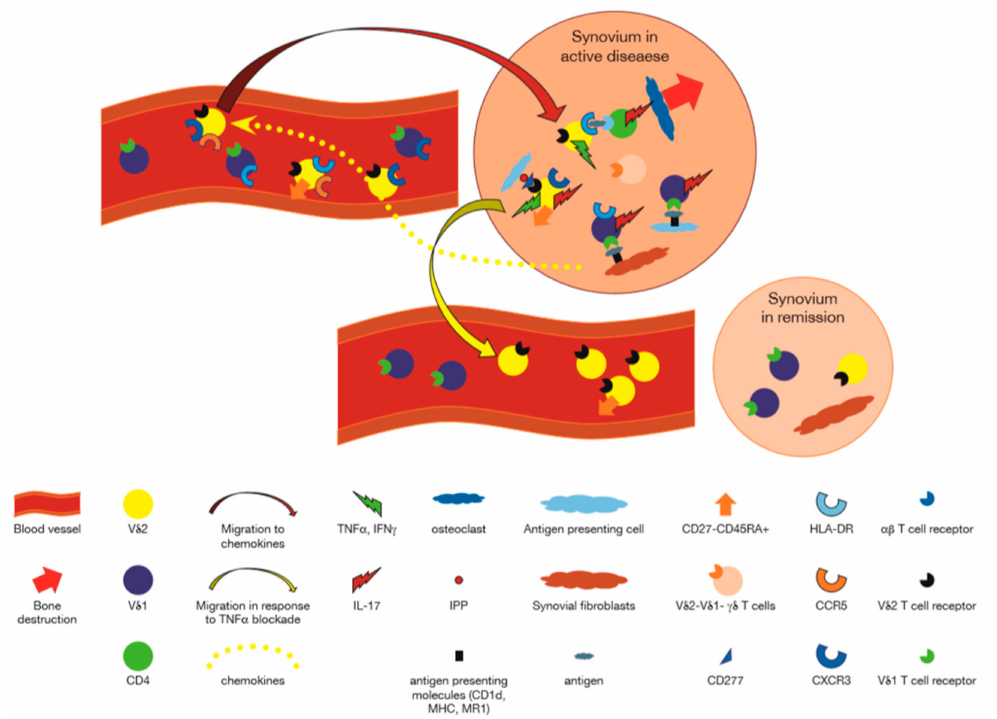
Figure 1. Participation of γδ T cells in Rheumatoid Arthritis. V δ 1 + γδ T cells using V γ 3, V γ 8 or other V γ genes, recognize antigens presented by CD1d or MR1 on synovial fibroblasts, and / or antigens presented by antigen presenting cells, and secrete cytokines such as interleukin (IL)-17, IL-4, and IFN γ [27,37,38,40,41,48]. Chemokines produced in inflamed synovium, attract C-X-C motif chemokine receptor (CXCR)5 and C-C motif chemokine receptor (CCR)3 expressing V γ 9 + T cells to the synovium [27]. These cells are activated by phosphoantigens presented by CD277 expressing cells in the synovium to express human leukocyte antigen (HLA)-DR, and in turn, may present antigens synovial reaction [35]. IL-17 secreted by CD4 + αβ T cells activated by V γ 9 + γδ T cells may attract neutrophils and lead to osteoclastogenesis. In the presence of anti tumor necrosis factor (TNF) α antibodies, chemokines retaining the V γ 9 + T cells are decreased, and these cells migrate out of the joint to the peripheral blood. Peripheral blood γδ T cells express activation markers acquired in lymph nodes or as a reflection of activation in the synovium